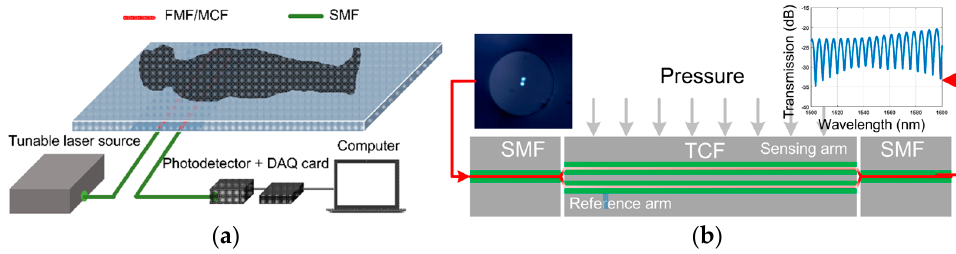
Figure 15. ( a ) Illustration of the vital signs monitoring experiment. The twin-core fiber (TCF)-based MZI is placed under the mattress. DAQ: data acquisition. ( b ) Schematic diagram of twin-core fiber MZI vibration sensor; the inset shows the interference spectrum of the measured twin-core-fiber-based MZI [43].